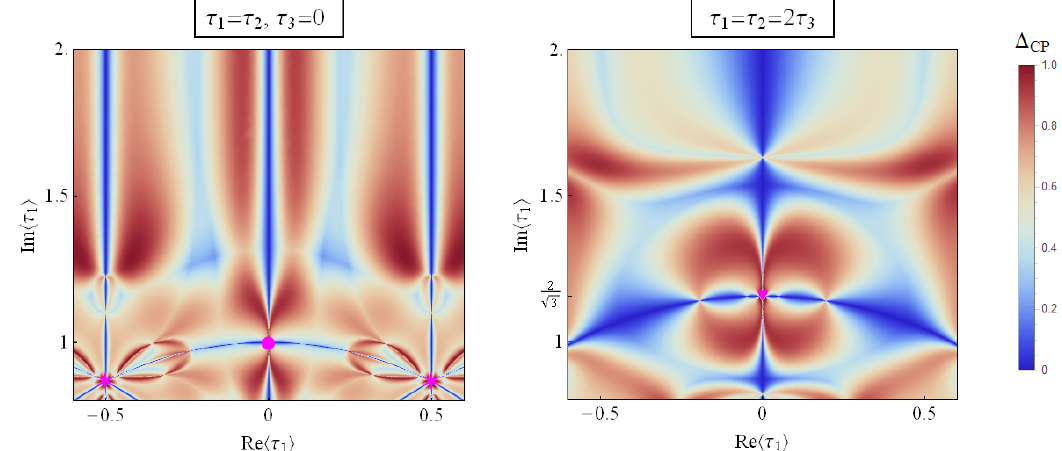
Figure 2: The distribution of CP violation measured by the average of the three CP phases ∆ in the subspace with τ CP (respectively right panel). In the subspace with τ | τ | = 1 are CP-conserving points. In the subspace with τ (cid:112) 1 | = 2 / and | τ 3 are CP-conserving points. The zero-dimensional fixed points 1 (cid:0) 2 1 (cid:1) (cid:0) ω 0 (cid:1) are marked by pink dot, hexagonal star and triangle, respec- and i (cid:112) 1 2 0 ω 3